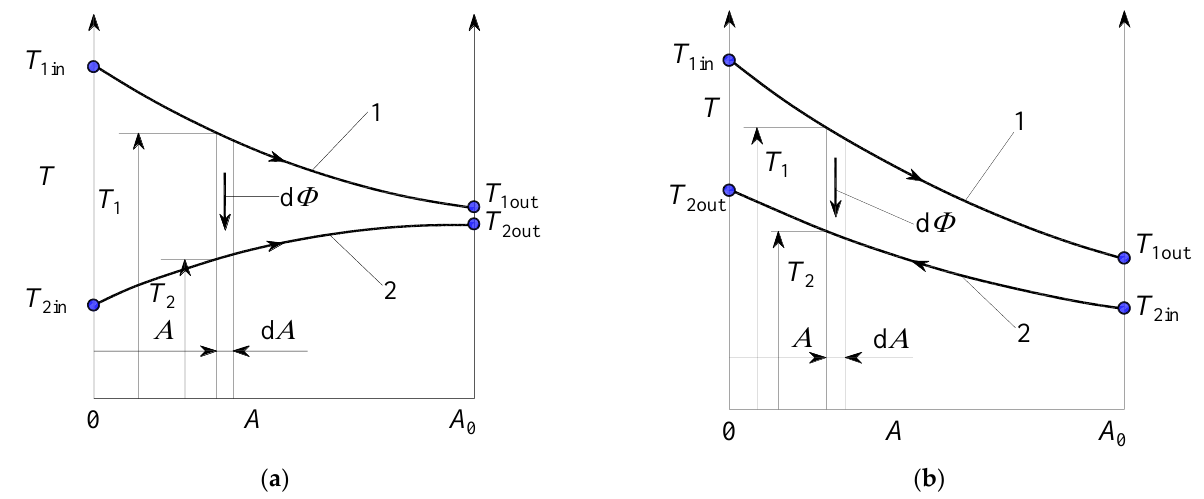
Figure 1. The derivation of local exergy destruction in ( a ) parallel-flow and ( b ) counter-flow heat exchangers.